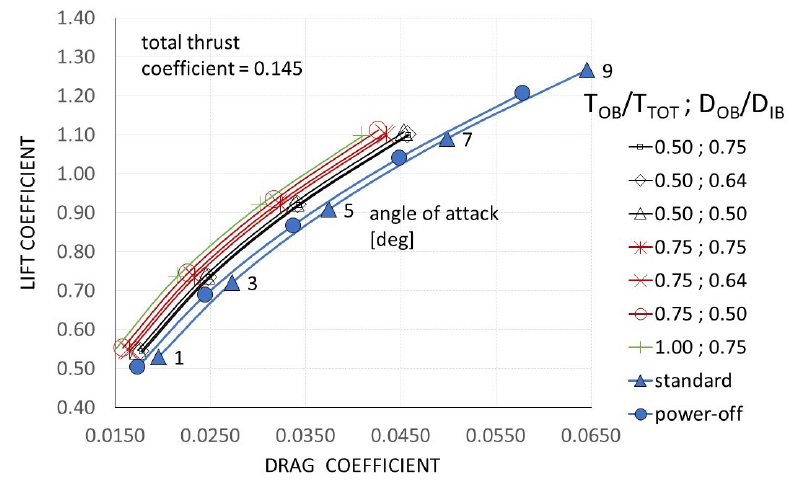
Figure 9. Drag polar curves: effect of IB and OB propellers at constant total thrust coefficient, climb conditions ( M = 0.251; Re = 12.8 × 10 6 ).